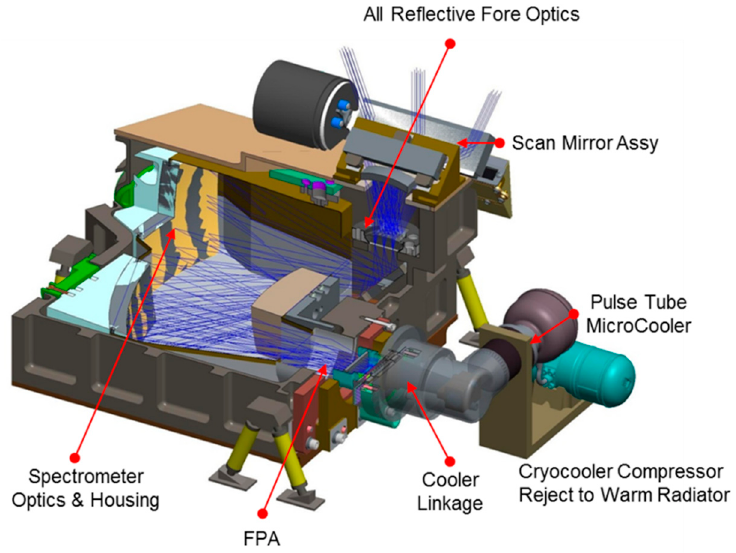
Figure 7. MISTiC IR spectrometer opto-mechanical concept shown in cut-away.